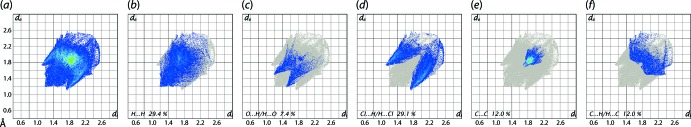
(a) A comparison of the full two-dimensional fingerprint plot for (I) and those delineated into (b) H⋯H, (c) O⋯H/H⋯O, (d) Cl⋯H/H⋯Cl, (e) C⋯C and (f) C⋯H/H⋯C contacts.